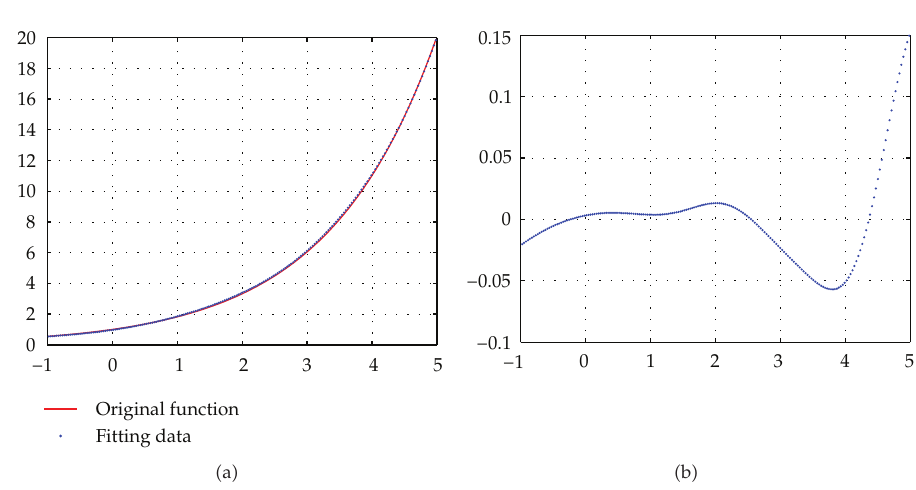
Figure 2: The fitting plot and its residual plot when h (cid:8) 0 . 5 and p (cid:8) 2: (cid:6) a (cid:7) fitting plot, (cid:6) b (cid:7) residual plot.